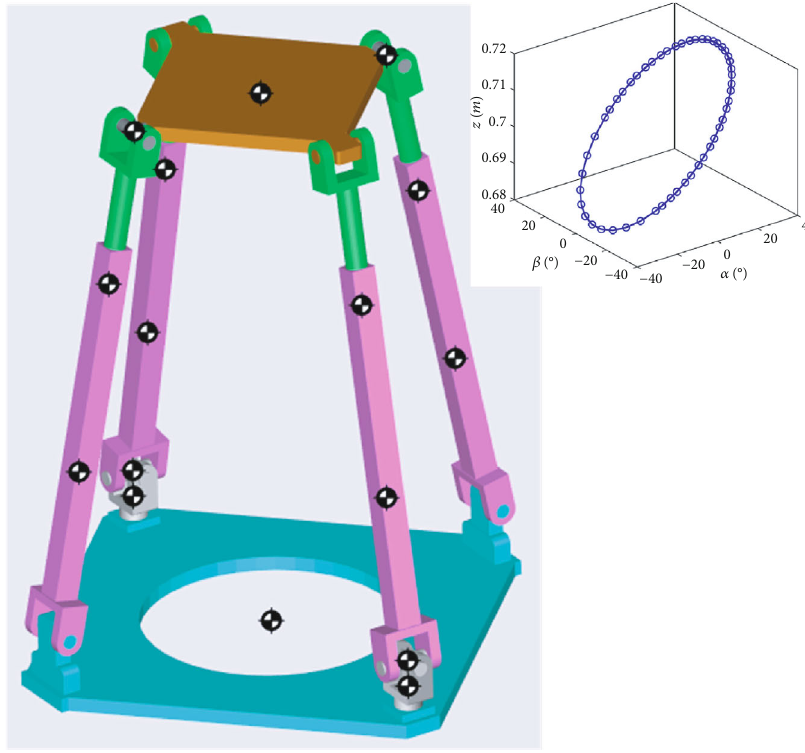
Figure 5: Parallel mechanism model in Simulink and desired trajectory.